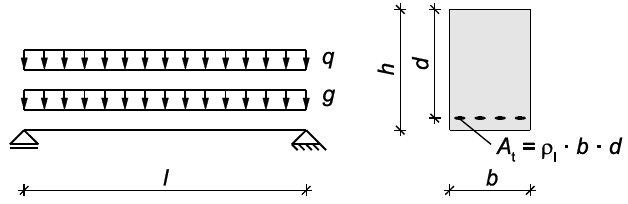
Figure 1. Structural system and dimensions of rectangular cross-section. Table 1. Overview of the geometric dimensions—statistical description of the basic variables [9].